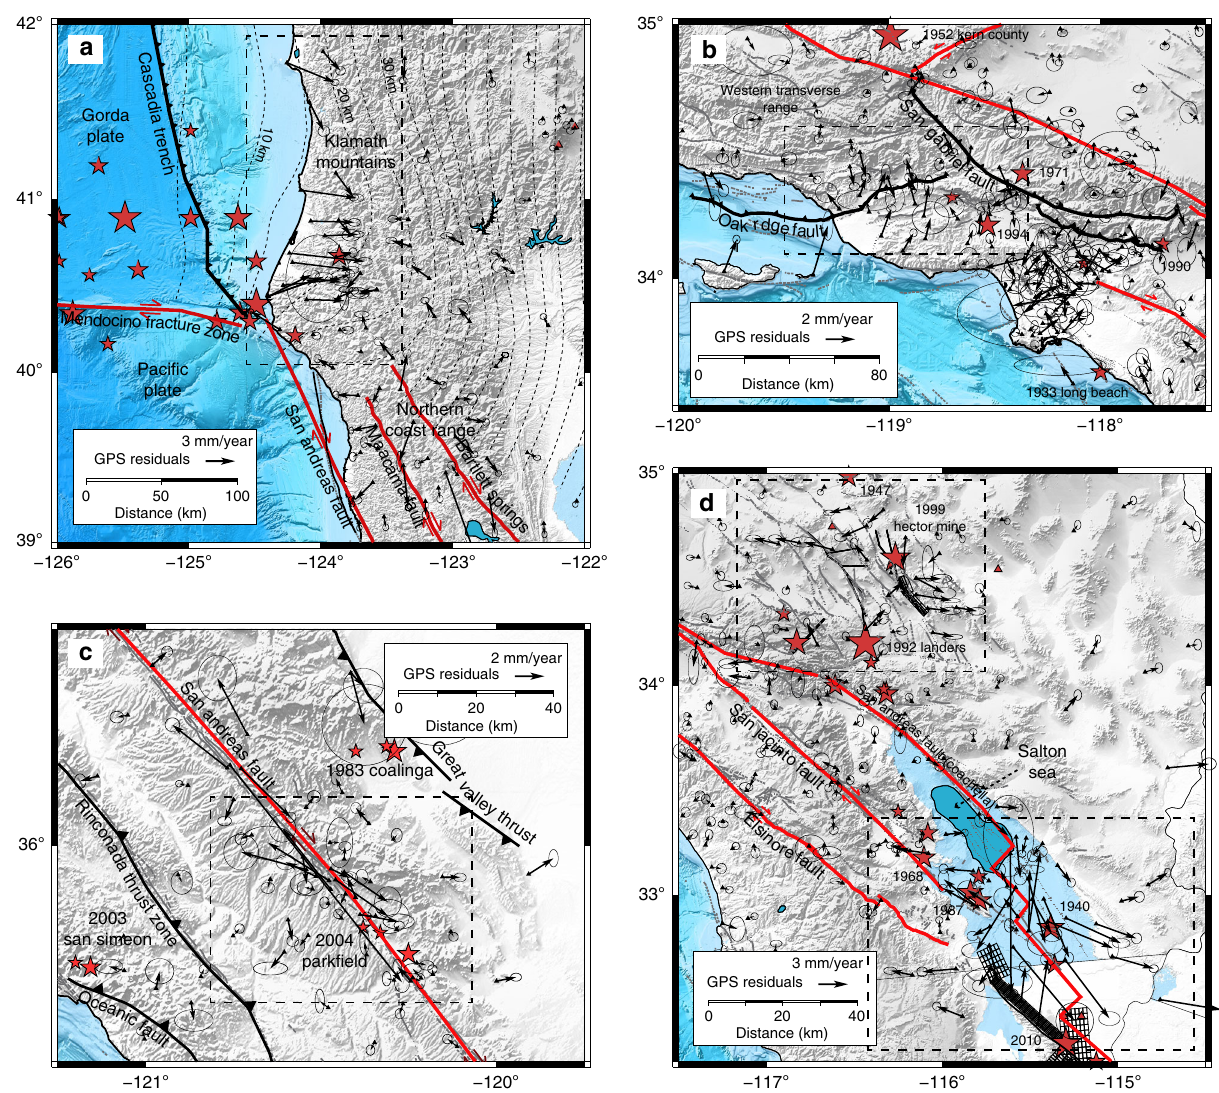
Fig. 5 Spatially coherent residuals. a Residual velocity in the northern California coast. Off the Gorda plate, the residuals are due to a shallow locked section of the Cascadia trench. The dashed lines are the 5-km contours of the Cascadia megathrust (https://earthquake.usgs.gov/data/slab/models.php). Diverging velocity in the northern Coast Ranges may be due to variation of water storage in aquifers. b Residual velocity around the Transverse Range due to shortening occurs across the Oak Ridge fault and the San Gabriel fault and in the Los Angeles Basin due to oil and gas extraction. The black lines with chevrons indicate major thrust faults. c Velocity residuals near the Park fi eld segment of the San Andreas fault due to complex shallow fault geometry, shallow creep, and afterslip from the 2004 Mw = 6.0 earthquake. d GPS residual velocity around the 1999 Mw = 7.1 Hector Mine earthquake and the 2010 Mw = 7.2 El Mayor-Cucapah earthquake in the Salton trough. The red stars indicate the hypocenter of historical earthquakes of magnitude <6 since